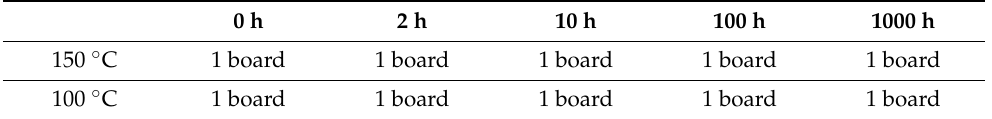
Table 1. Combinations of thermal aging time and temperature.